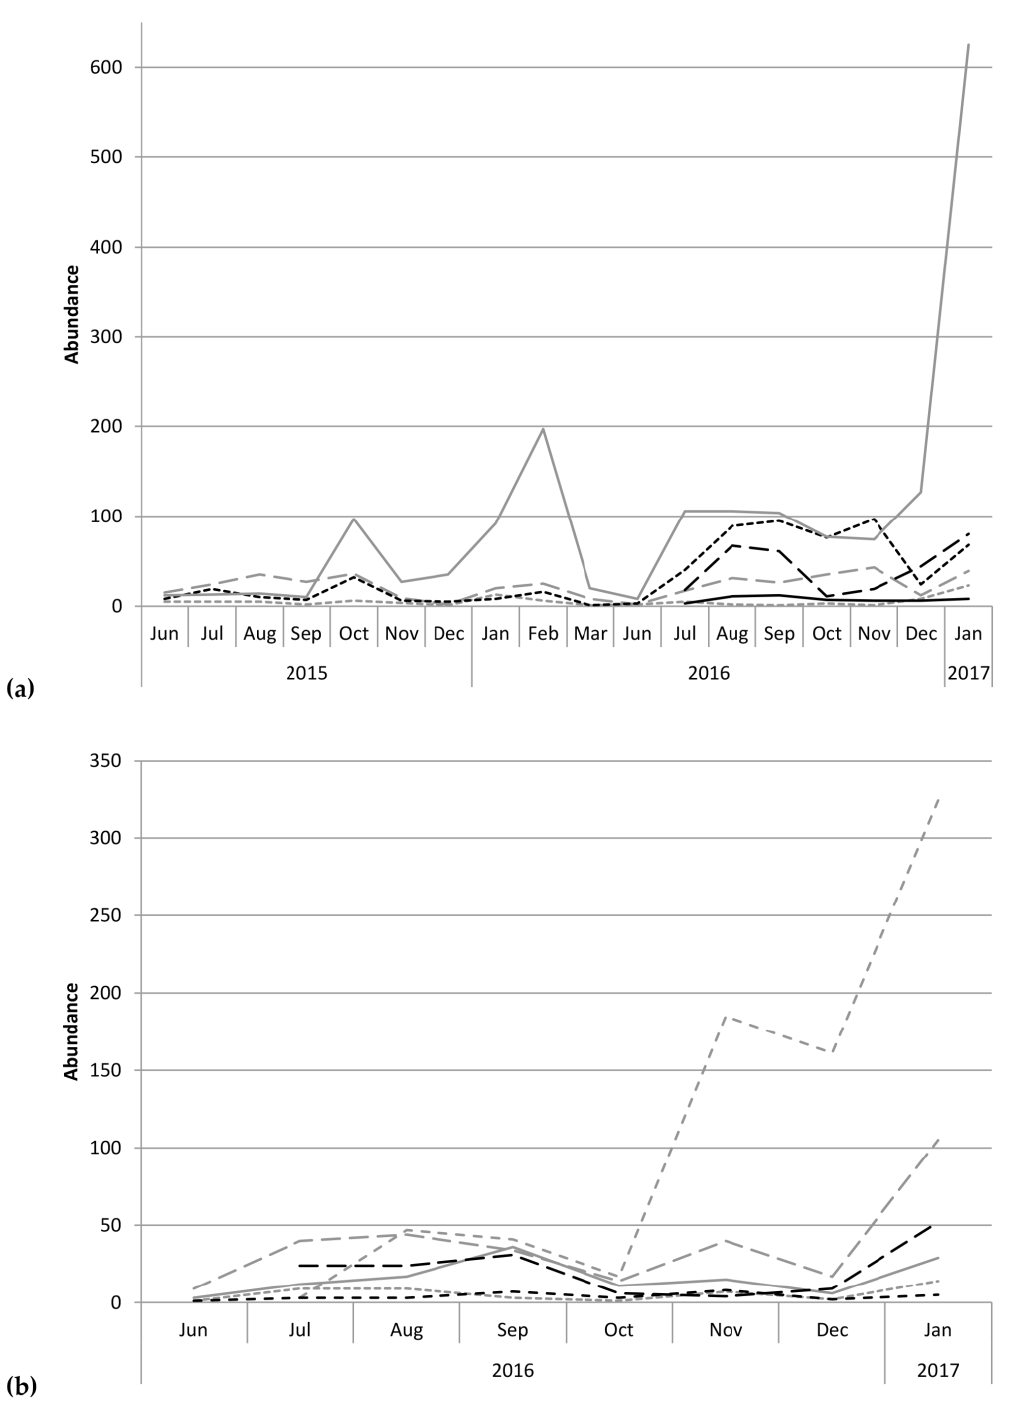
Figure 2. Abundance over time of the six most prominent scolytines at ( a ) the Kaua ʻ i Coffee Company during the 2015–2016 and 2016–2017 growing seasons, and ( b ) Moloa ʻ a Bay Coffee during the 2016–2017 growing season. Grey solid = Hypothenemus obscurus , black long dashes = H. seriatus , black dots = H. birmanus , grey medium dashes = H. eruditus , grey dots = Cryphalus longipilus , black solid = H. brunneus , grey short dashes = Xylosandrus compactus , black short dashes = X. crassiusculus .